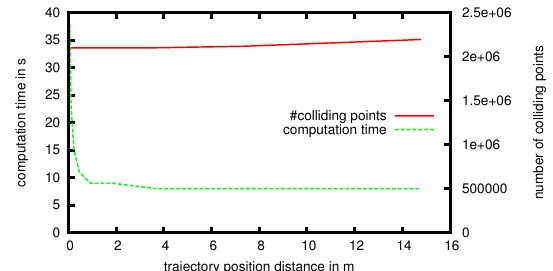
Table 1: The first column shows the choice of collision detection search radius r . The second column shows the resulting distance between the points of the wagon d m and the points on the trajec- tory d t . The third column shows the resulting number of points in the model. The fourth column shows the resulting number of points on the trajectory. The second and fourth column are ex- tended as the results in figure 5b are calculated for higher distance values as well. √ r in m d m = d t = 2 3 r 3 (a) Computation time of both collision detection variants with different search radii r . The distance between individual points on the trajectory d t and the distance between points in the model d m is chosen to be d t = d m = 0 . 231 m .